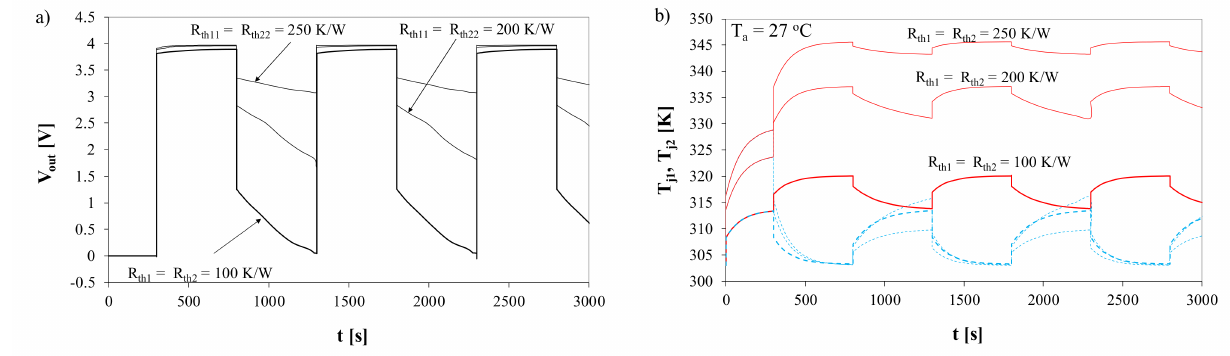
Figure 17. Waveforms of the output voltage ( a ) and the internal temperature ( b ) in the differential amplifier without thermal couplings.